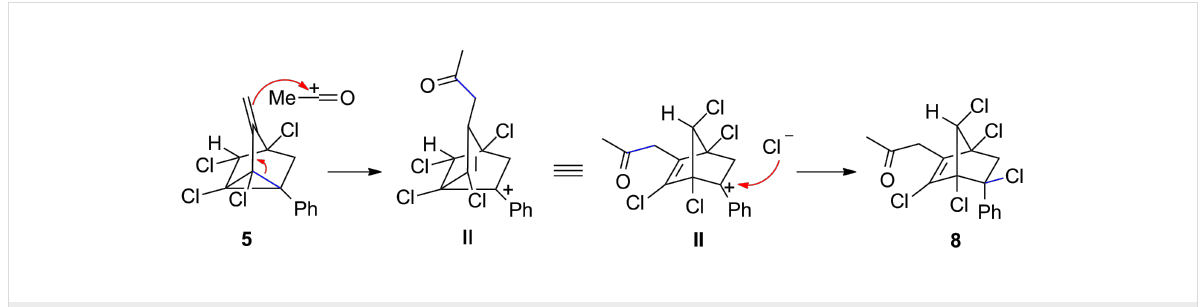
Scheme 5: Plausible mechanism of the acylation reaction of 3-methylenenortricyclenes.